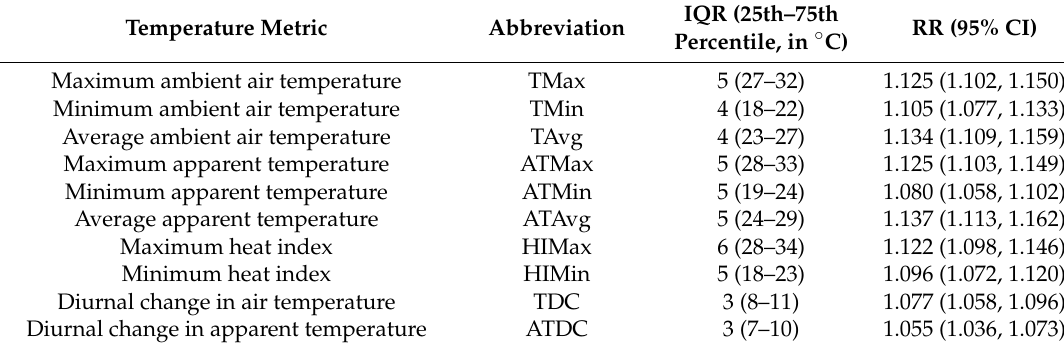
Table 3. Estimated rate ratios (RR) for all fluid and electrolyte imbalance emergency department (ED) visits in relation to a change of approximately 1 IQR (from the 25th to 75th percentile) for various temperature metrics in Atlanta during the warm seasons (May–September), 1993–2012 ( n = 3060 days).